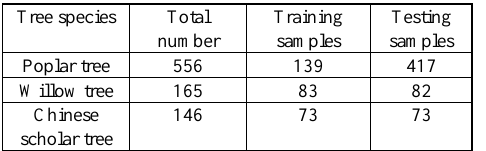
Table 1. Ground reference data in number of trees used in the classification.